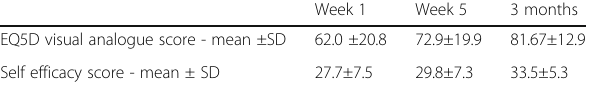
Table 2 (abstract 000057). Patient outcomes